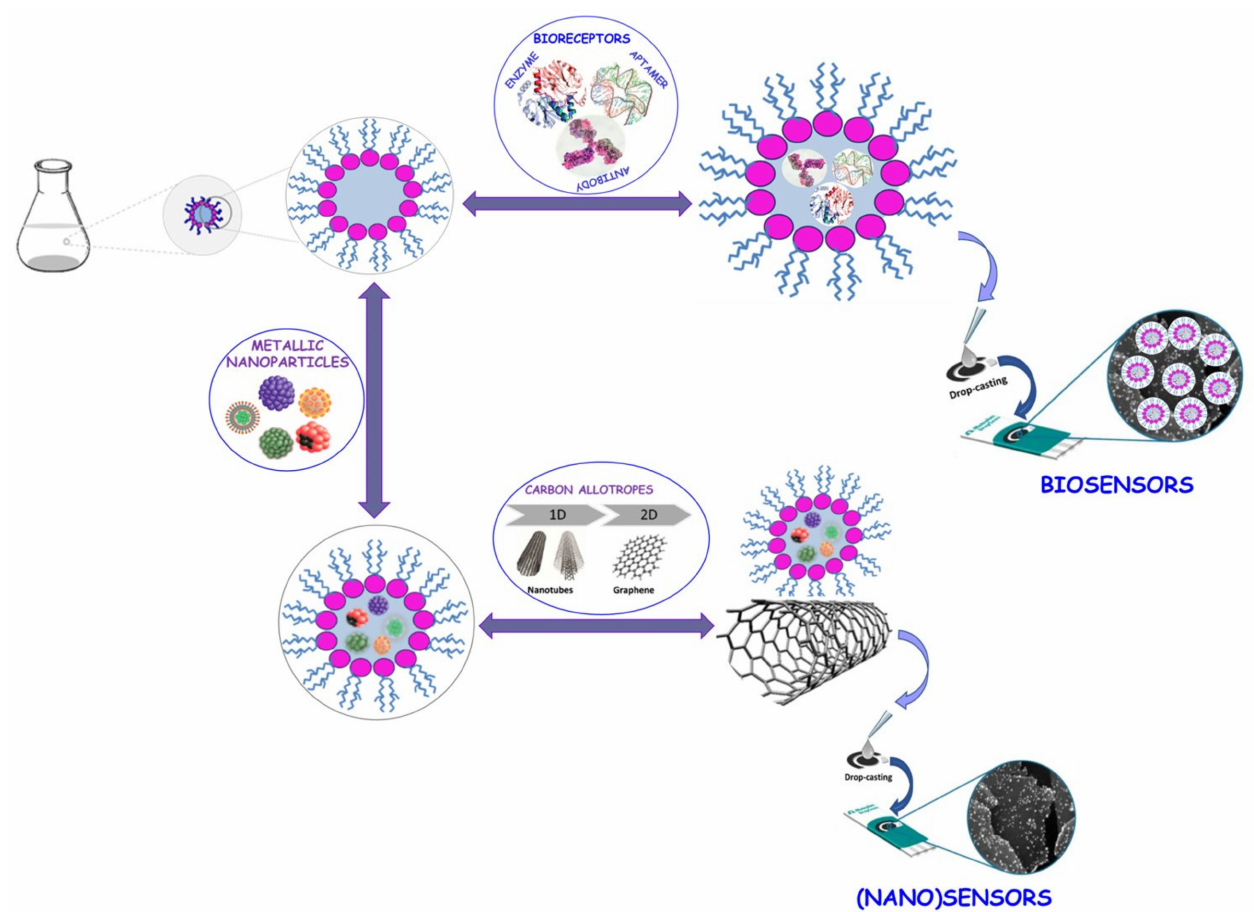
Figure 10. Nano (bio)sensor design using reverse